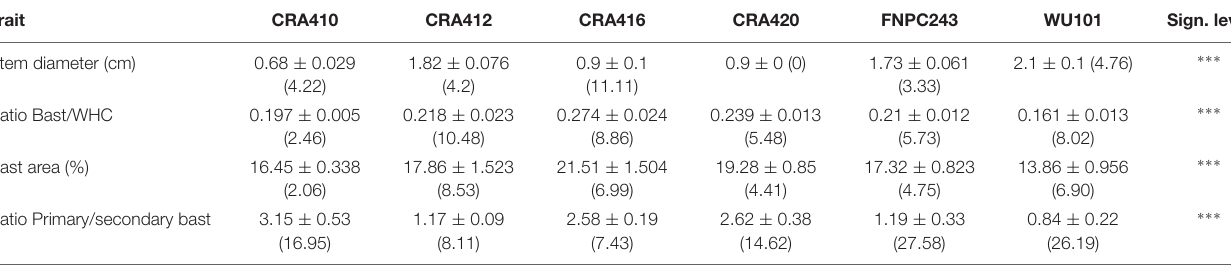
TABLE 5 | Stem morphology characteristics of six contrasting hemp accessions.